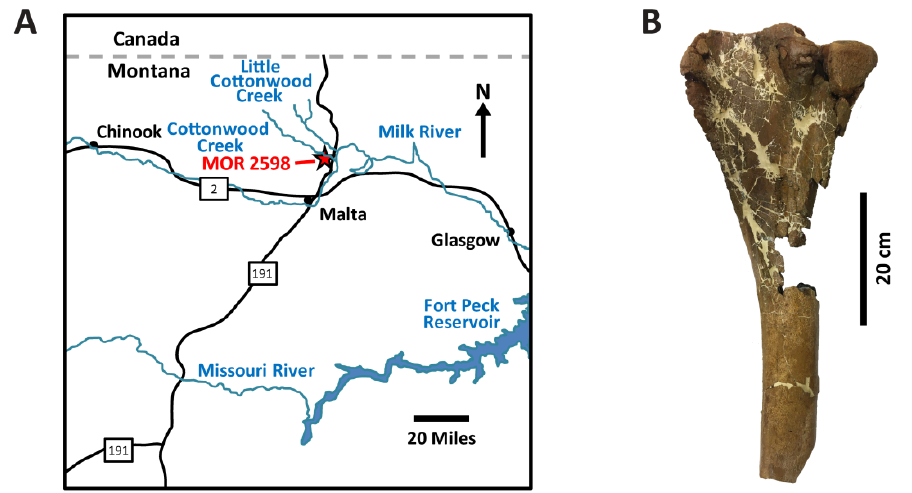
Figure 1. ( A ) Map showing the locality from which MOR 2598 was recovered in Phillips County, Montana. ( B ) Left tibia of MOR 2598 examined in this study, shown in lateral view. Map redrawn and modified from [75].